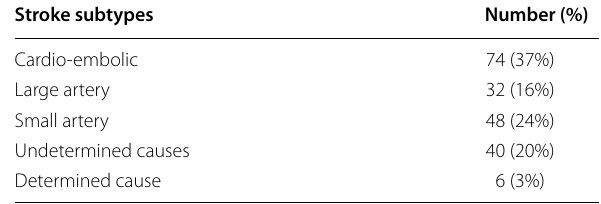
Table 6 Vertebrobasilar dolichoectasia and cerebral microbleeds